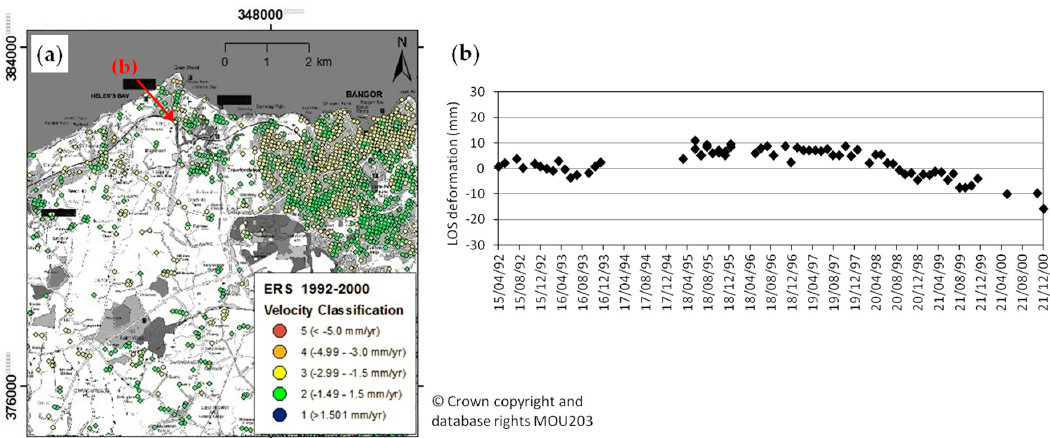
Figure 12. ( a ) Observed ground deformation and ( b ) time series for 1992–2000 in the area of the Belfast–Bangor railway line at Skelly Hill. Reproduced from Land and Property Services data with the permission of the Controller of Her Majesty’s Stationery Office, © Crown copyright and database rights MOU203.